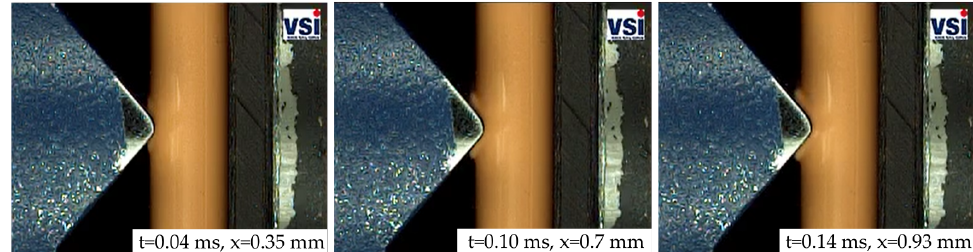
Figure 8. Exemplary high-speed sequences from a dynamic SHPB test on a PA12 busbar in combina- tion with impactor V1.